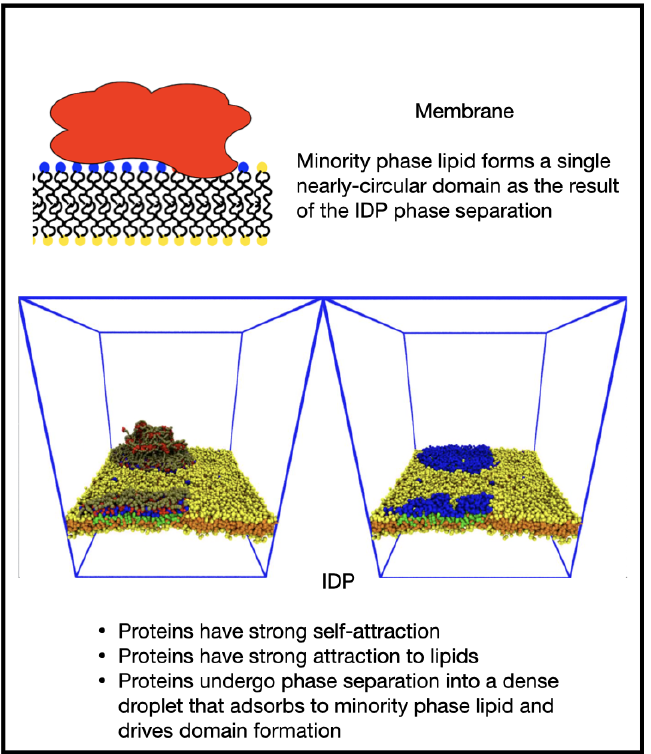
Figure 7. When both IDP self-attraction and the IDP–membrane attraction are strong, the proteins undergo phase separation into a dense droplet that adsorbs to the minority phase lipids driving domain formation but still protrudes into bulk